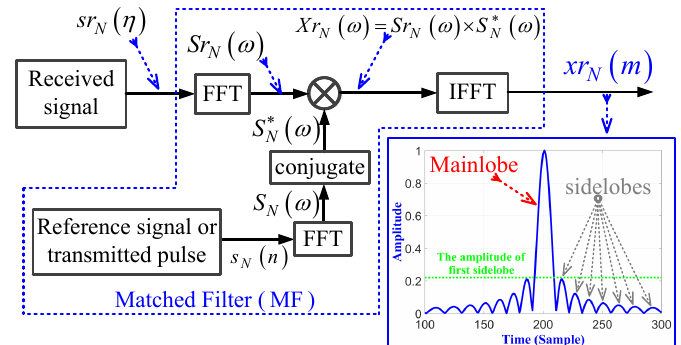
Figure 2. Block diagram of the conventional